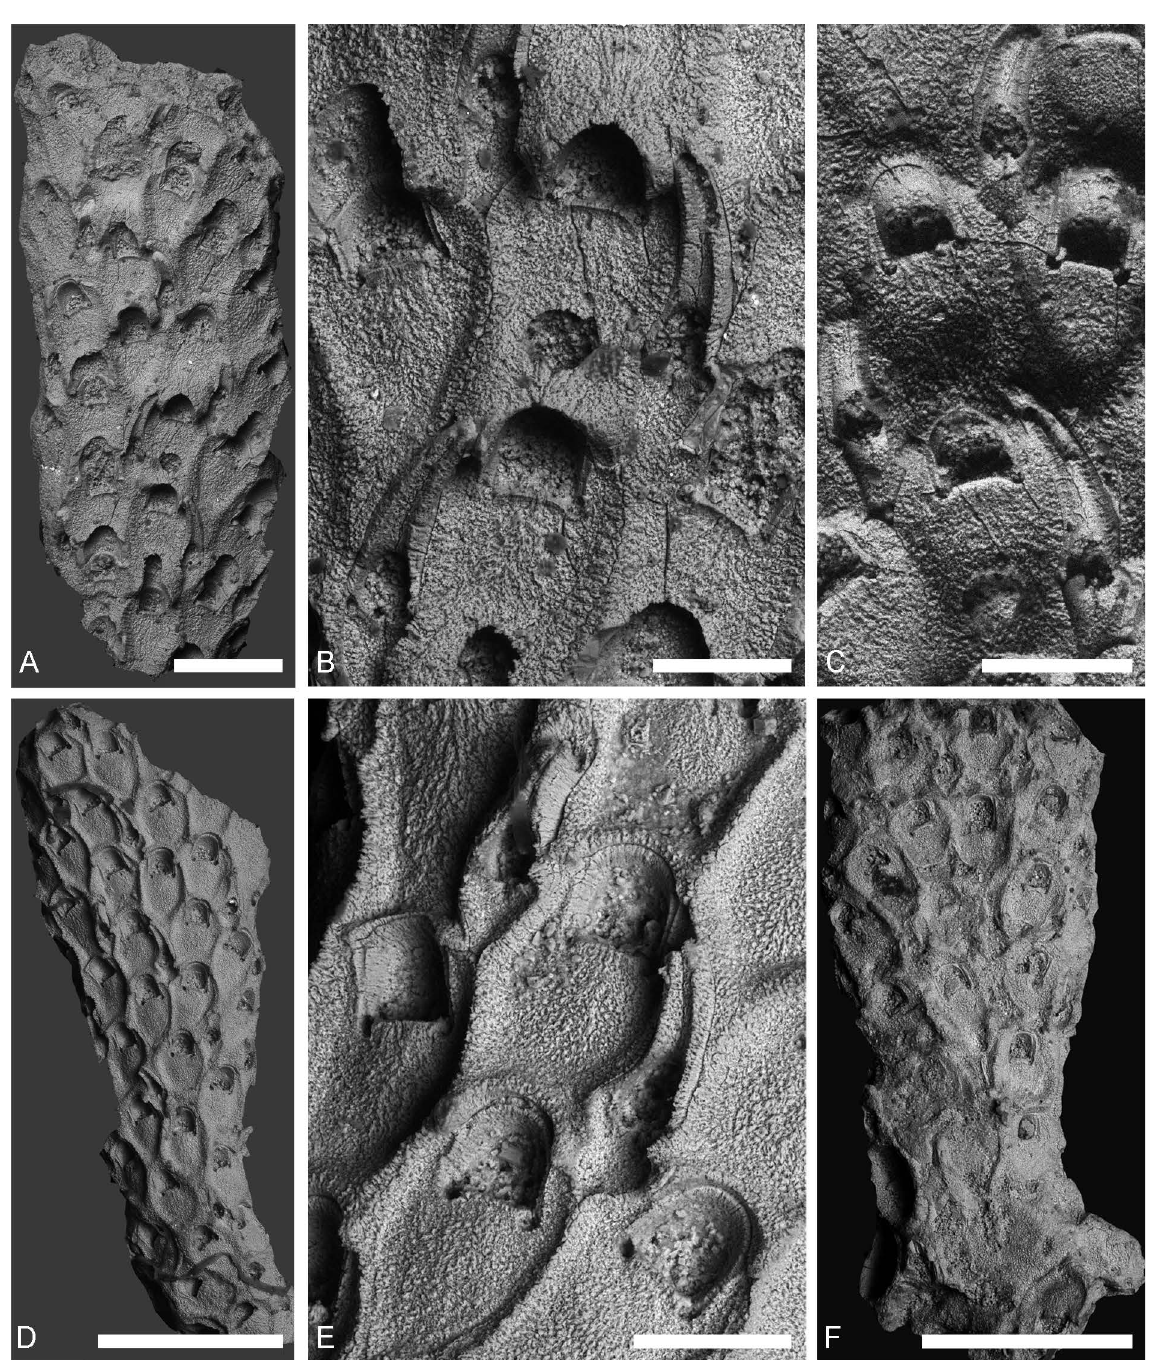
Fig. 15. Rhagasostoma tchvanovi (Favorskaya, 1992). A–E . Late Campanian ( Cibicidoides voltzianus Zone; LS15), southern Aral Sea Region, Republic of Karakalpakstan, Uzbekistan. A–C . Holotype, TsNIGR Museum 33/12582. A . Overview of erect bifoliate colony. B . Ovicellate autozooids and avicularia. C . Non-ovicellate autozooids and avicularia. D–E . TsNIGR Museum 34/12582. D . Overview erect bifoliate of colony. E . Non-ovicellate autozooids and avicularia. F . TsNIGR Museum 32/12582, middle Campanian ( Brotzenella monterelensis Zone; LS14), southern Aral Sea Region, Republic of Karakalpakstan, Uzbekistan; overview of erect bifoliate colony, cryptocyst of autozooids with proximolateral caverns. Scale bars: A = 500 µm; B, E = 200 µm; С = 250 µm; D, F = 1